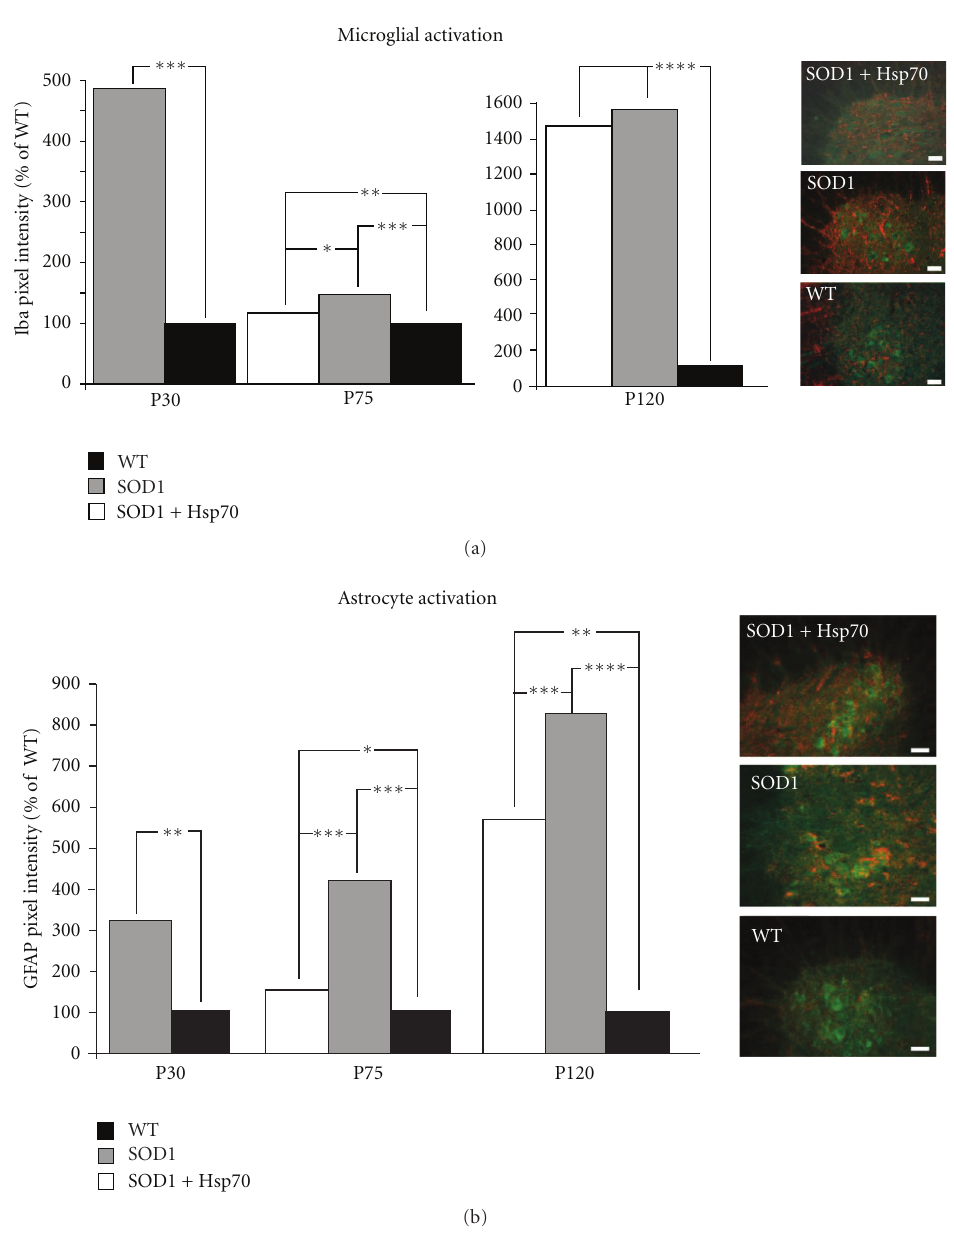
Figure 5: rhHsp70 injections attenuate early glial cell activation. (a) The fluorescent pixel intensity of Iba1 staining for microglia was increased in the SOD1 versus WT animals at P30 and P75. Treatment with rhHsp70 appeared to reduce the expression of Iba1 at P75, but the levels were greater than WT animals. Pixel intensity was measured using Image J software. Each fluorescent pixel in the section was measured and the values were compiled and averaged across each treatment group. Histograms represent the average number of pixels in a given range of arbitrary intensity units presented as % WT. Statistical significance was determined using a two-way ANOVA at P30 and a repeated measure (mixed model) ANOVA at P75 on all of the measured values above baseline ( ∗∗∗ P ≤ 0 . 001; ∗∗ P ≤ 0 . 01; ∗ P ≤ 0 . 05). N = 4 for each group. Images of the lateral motor column of P75 mice that were treated with Hsp70, untreated, or WT are shown on the right. 30 μ m spinal cord sections were stained with Iba-1 (red) and ChAT (green). Scale bars = 20 μ m. (b) GFAP expression was the greatest in SOD1 animals as compared to WT at P30 and P75. Treatment with rhHsp70 substantially reduced the expression of GFAP in SOD1 animals. Quantification of fluorescence and statistical analysis was performed as described above. Images of the ventral horn of P75 mice that were treated with Hsp70, untreated, or WT are shown on the right. 30 μ m spinal cord sections were stained with GFAP (red) and ChAT (green). Scale bars = 20 μ